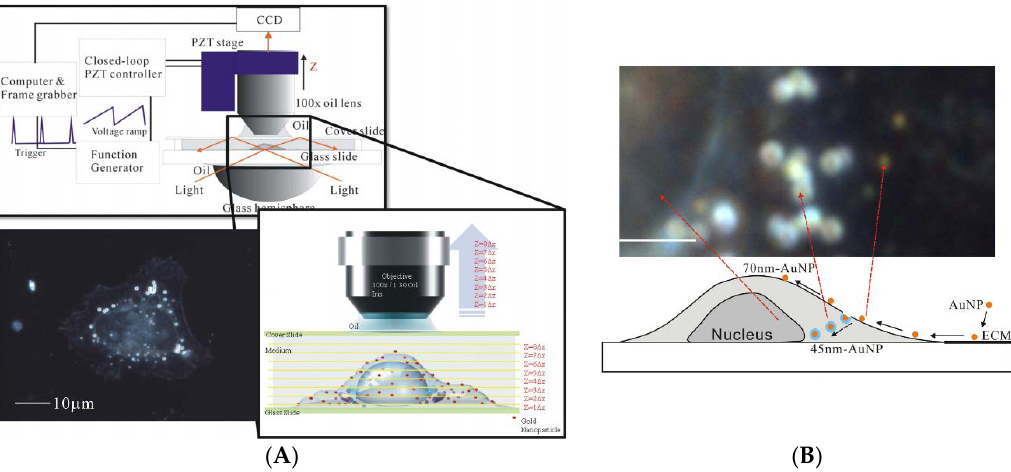
Figure 2. ( A ) The optical setup of the DFM microscope used by Wang et al. A light source of 60 W metal halide light illuminates the samples through a hemisphere glass lens. The scattered light is collected by an objective lens and imaged by a color CCD. The scattering images can be collected at different focal positions; ( B ) A dark-field CCD image for 45- and 70-nm-AuNPs and a CL10 cell with a focus plane fixed at the glass substrate. The AuNPs uptaken by the cells became orange with blue surroundings. (Reproduced from [76] with permission).